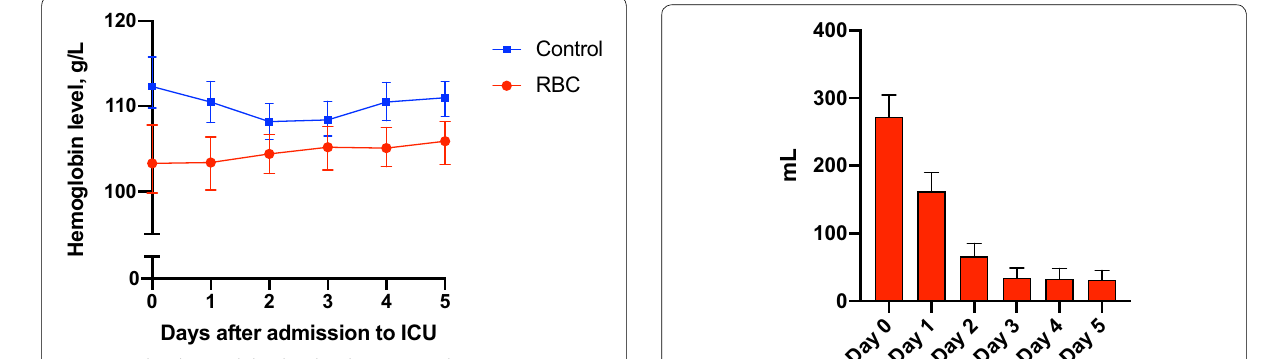
Fig. 2 Median hemoglobin level with interquartile range. RBC group with patients who received red blood cell transfusion = any of the first 5 days